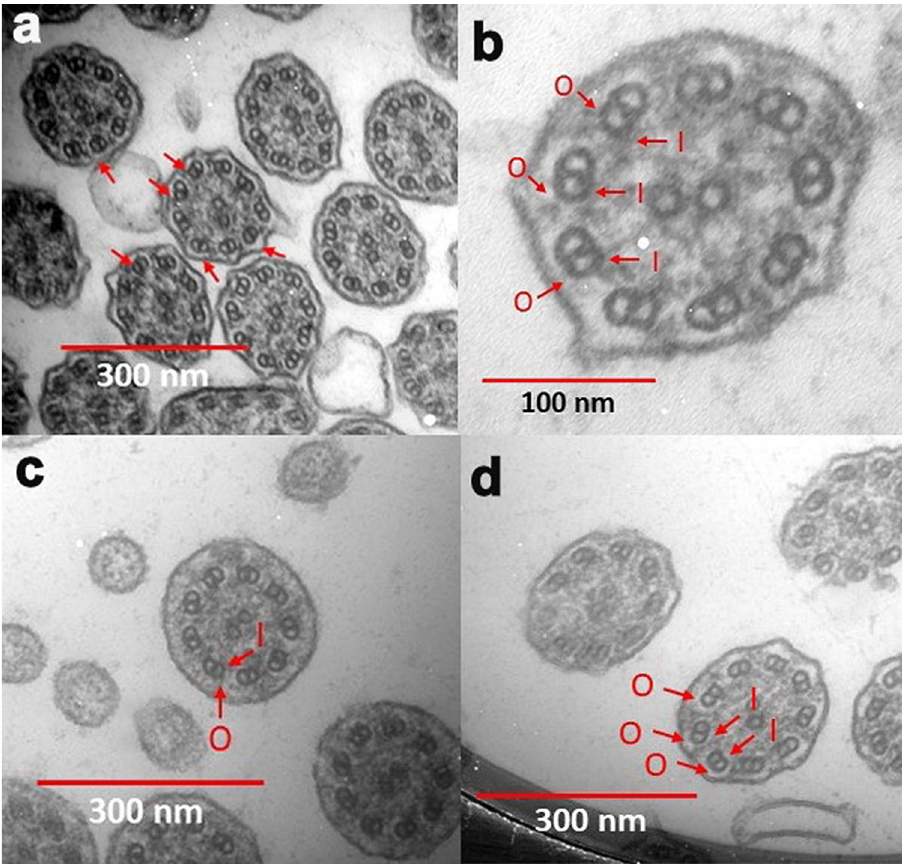
Figure 6. IDA and ODA defects. ( a ) ODA defects (arrows). ( b , c , d ) Some absence of IDA (I) and ODA (O) are marked. (Original magnification: a , c & d : ×50,000, b : ×140,000).